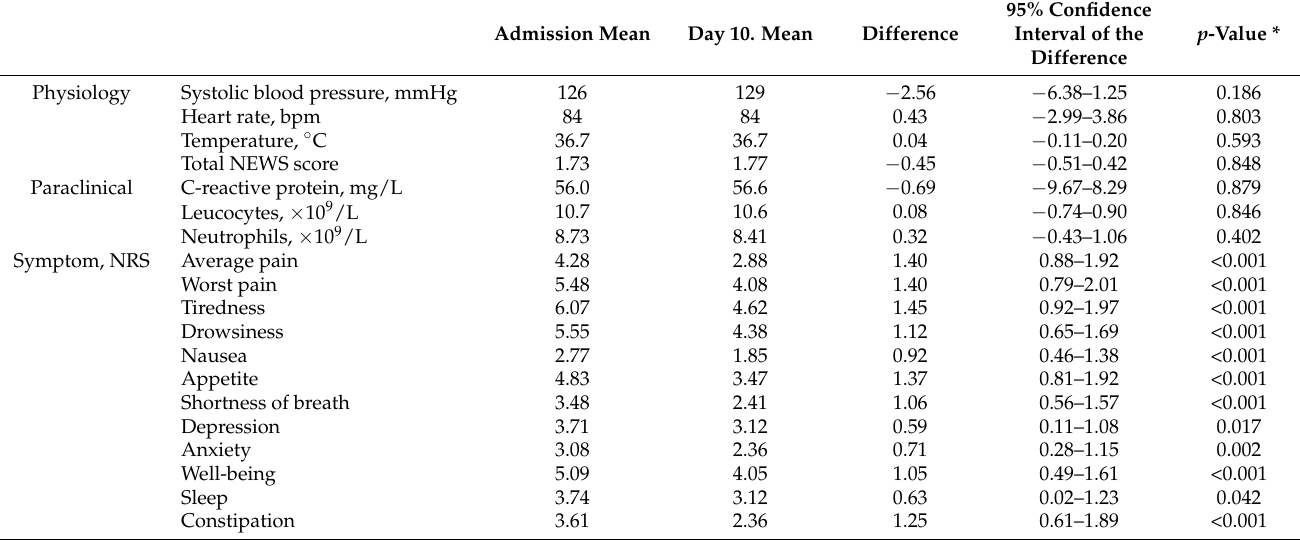
Table A2. Course of disease during stay, non-infection group, n =